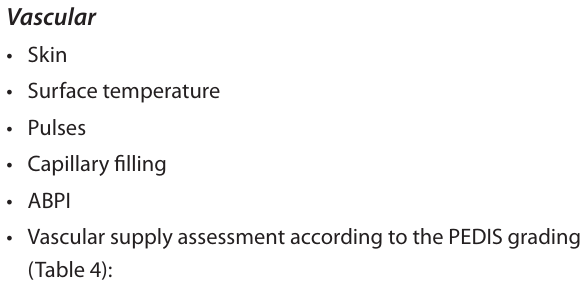
Table 4: Adapted PEDIS grading 5,45